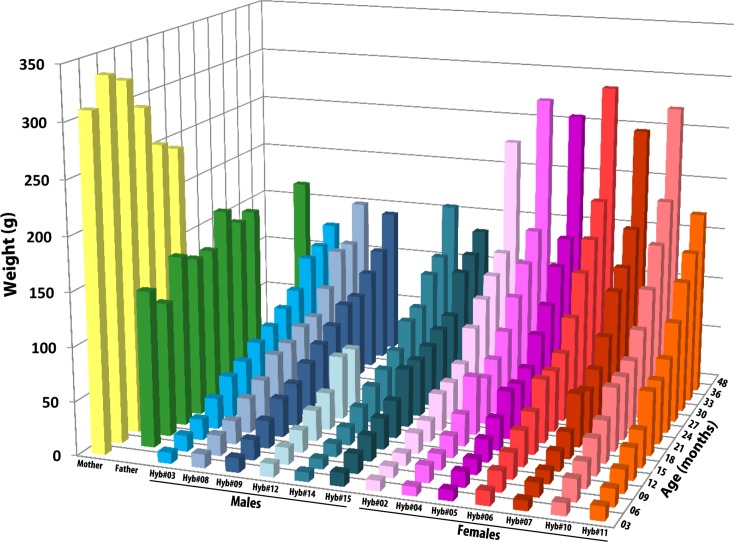
Growth of F1 hybrids determined by weight gain over time.The weights for the father and mother are also shown in the figure for comparison.